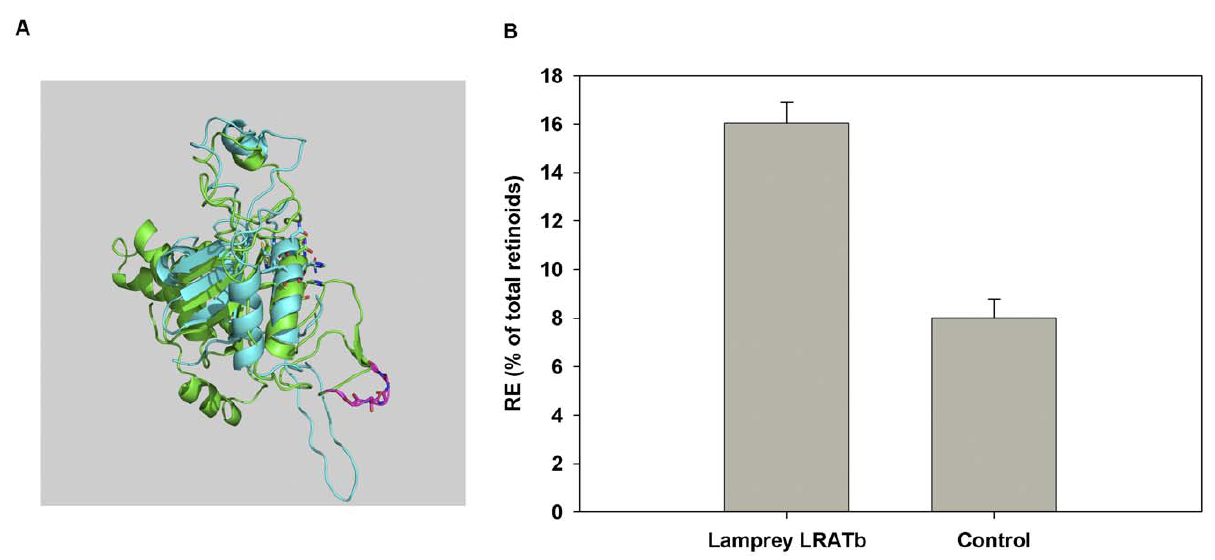
Figure 4. Functional LRAT is expressed in Lamprey RPE. A: Superposition of Lamprey LRATa and LRATb models on the H-REV107 crystal structure template (PyMol). Blue , Lamprey LRATa sequence. Green , Lamprey LRATb sequence. Magenta , 7-glycine motif on LRATb sequence. Side chains of a highly conserved LWNNCEHF motif with catalytic cysteine are shown in sticks, with red, oxygen; blue nitrogen and yellow , sulfur. B: Catalytic activity of Lamprey LRATb in HEK293F cells in the presence of specific DGAT1 inhibitor (A922500, 50 m M). Activity is expressed as ratio of retinyl esters to total retinoids (retinols and retinyl esters in %).